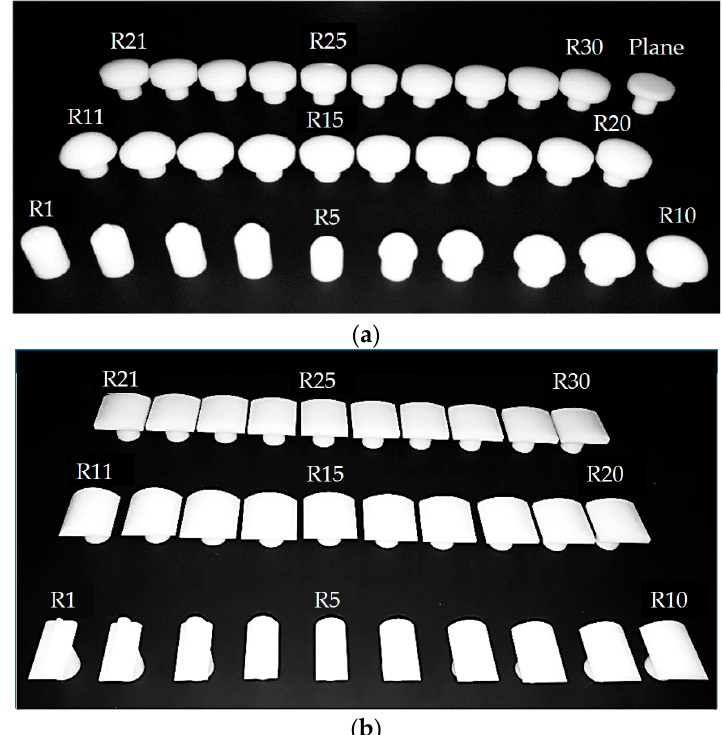
Figure 8. Experimental samples for object curvature discrimination: ( a ) samples of convex sphere and plane objects; ( b ) samples of convex cylindrical objects.